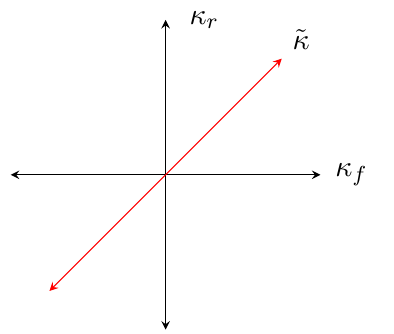
Fig. 1 The two-dimensional space of scale variations for a single pro- cess: κ r is the renormalization scale (giving the MHOU in the hard cross-section), κ f is the factorization scale (giving the MHOU in the evolution of the PDF) and ˜ κ is the variation of the scale of the process (called factorization scale variation in the earlier literature), obtained by setting κ f = κ r